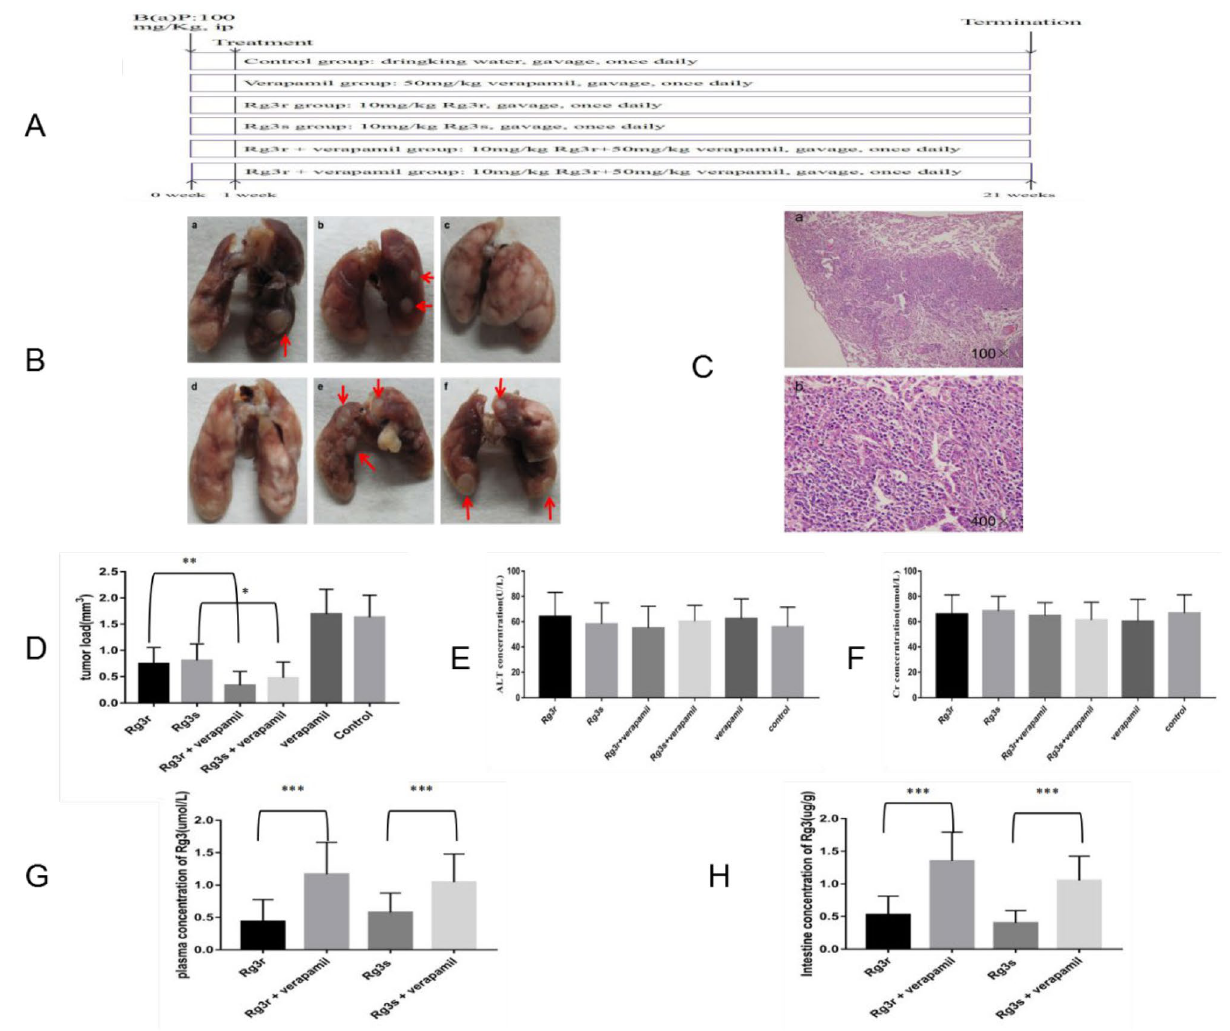
Figure 4. The tumor load after G-Rg3 treatment and the levels of G-Rg3r and G-Rg3s in the plasma or intestine in the indicated groups. ( A ) Experimental design. ( B ) Gross tumors in the murine model. Tumors are indicated by arrows. a: G-Rg3r. b: G-Rg3s. c: G-Rg3r combined with verapamil. d: G-Rg3s combined with verapamil. e: Verapamil. f: Control. ( C ) Light photomicrographs of tumors with magnification at. a: 100X. b: 400X. ( D ) G-Rg3 + verapamil treatment on tumor load in A/J mice. (E) The plasma levels of the liver enzyme ALT. (F) The plasma levels of the kidney enzyme Cr. (G) Levels of G-Rg3r or G-Rg3s in the plasma of the indicated groups. (H) Levels of G-Rg3r or G-Rg3s in the intestine of the indicated groups. The data is presented as the mean ± SD of triplicate assays. * P < 0.05, ** P < 0.01, *** P <